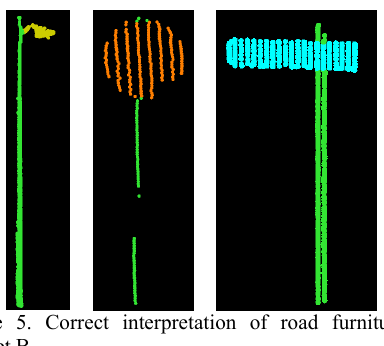
Figure 5. Correct interpretation of road furniture in Dataset B